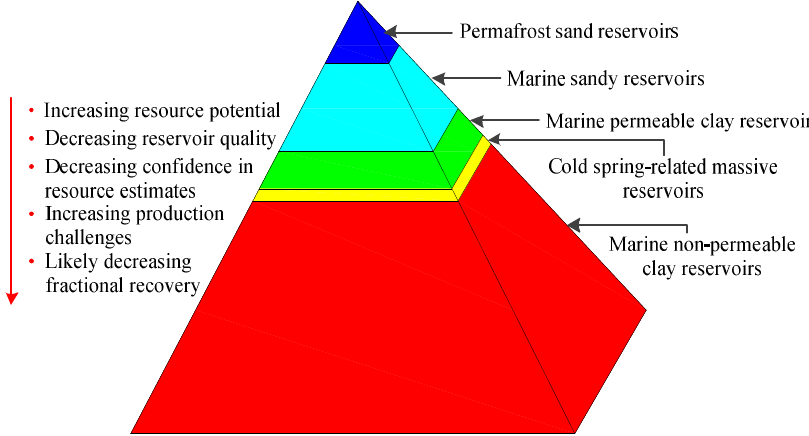
Figure 10. The pyramid of NGH exploitation difficulty [53].